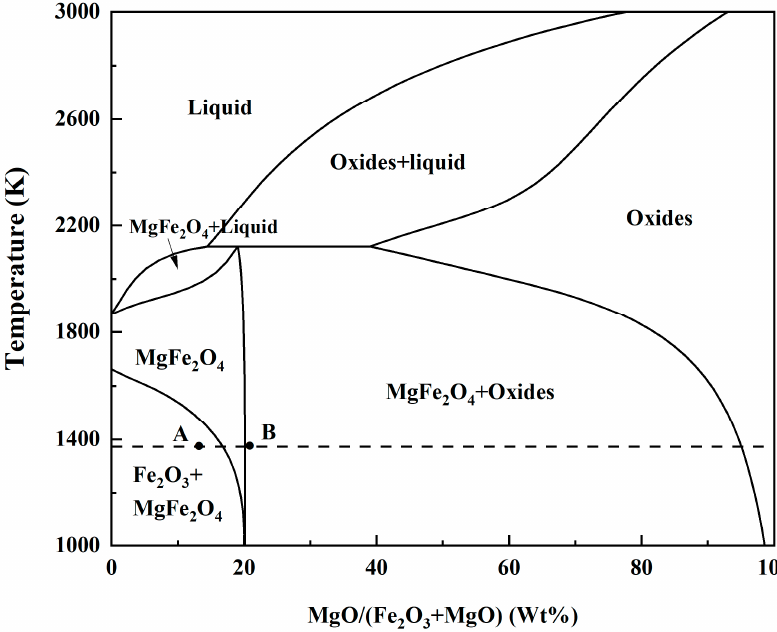
Figure 7. Phase diagram of Fe 2 O 3 -MgO in air (P(O 2 ) = 0.21 atm). Point A: The composition of the sintered product under a low MgO content; Point B: The composition of sintered products under pure MgFe 2 O 4 spinel conditions.